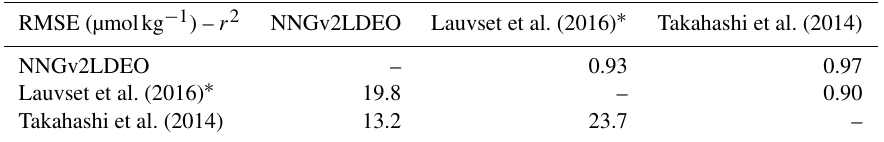
Table 6. Comparison of four annual mean surface climatologies of TCO 2 . Numbers in the lower left corner represent RMSE. Numbers in the upper right corner represent r 2 .